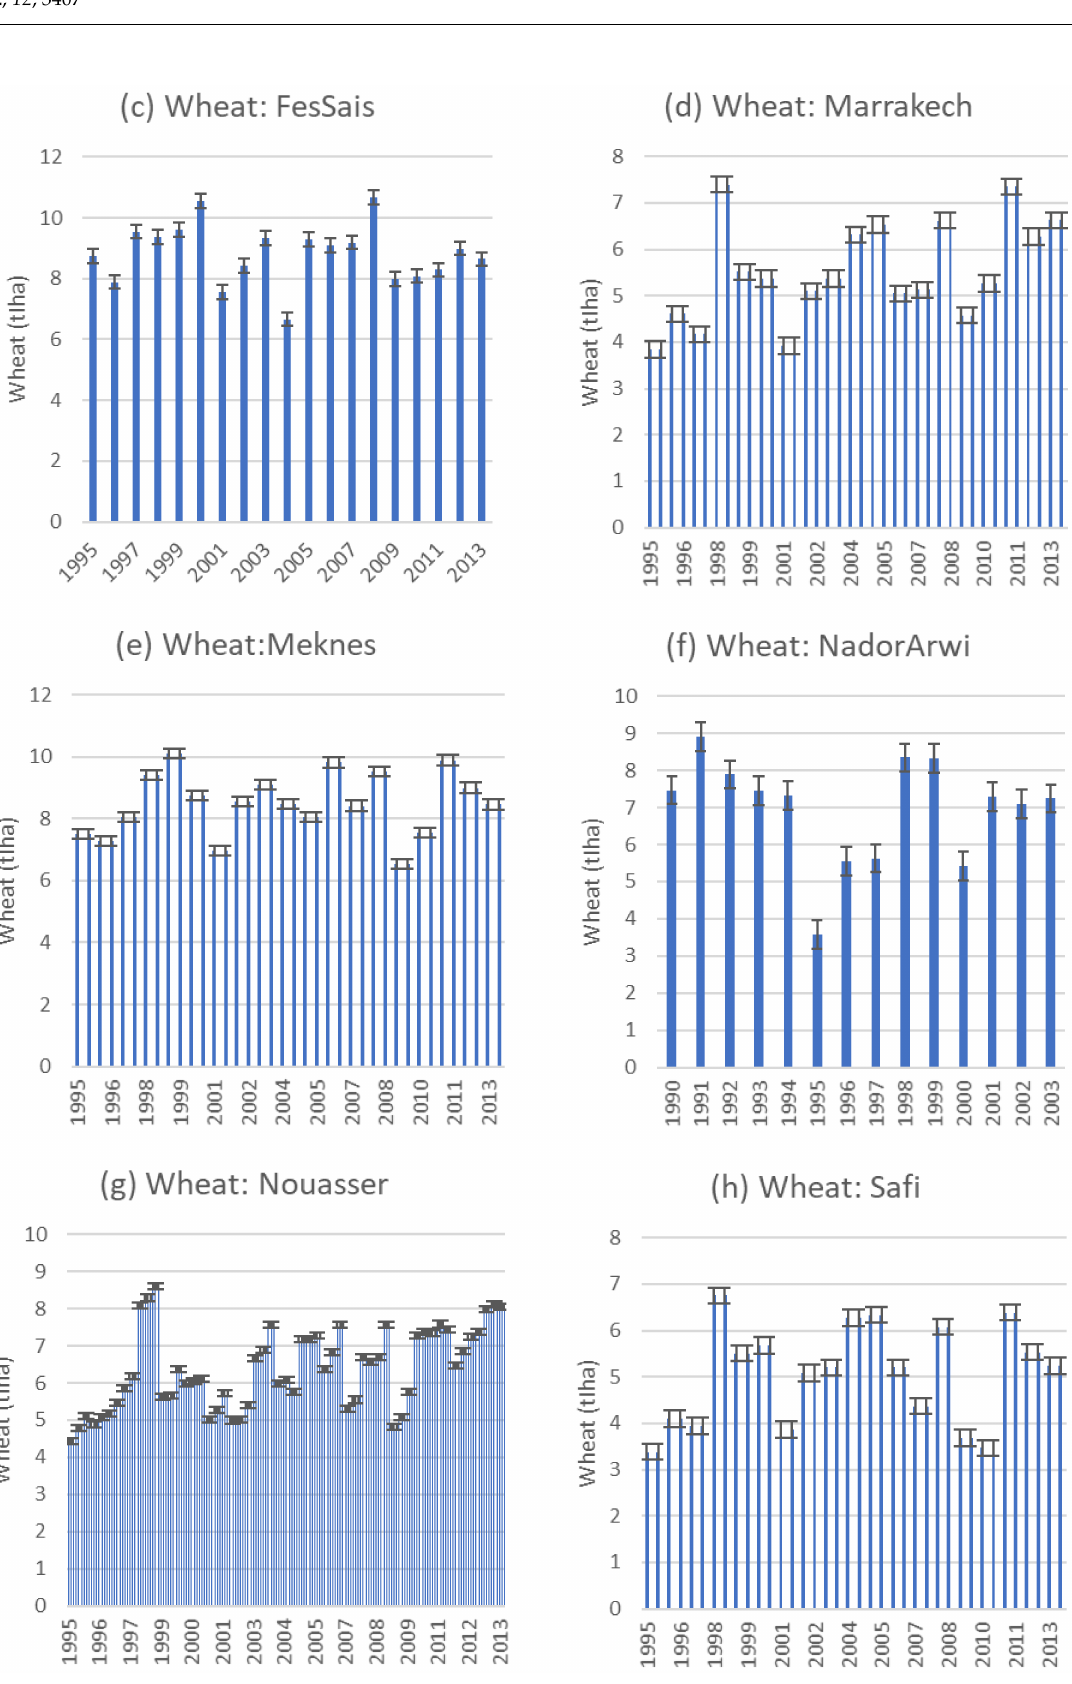
Figure 9. Variations in wheat yield over time in various stations in